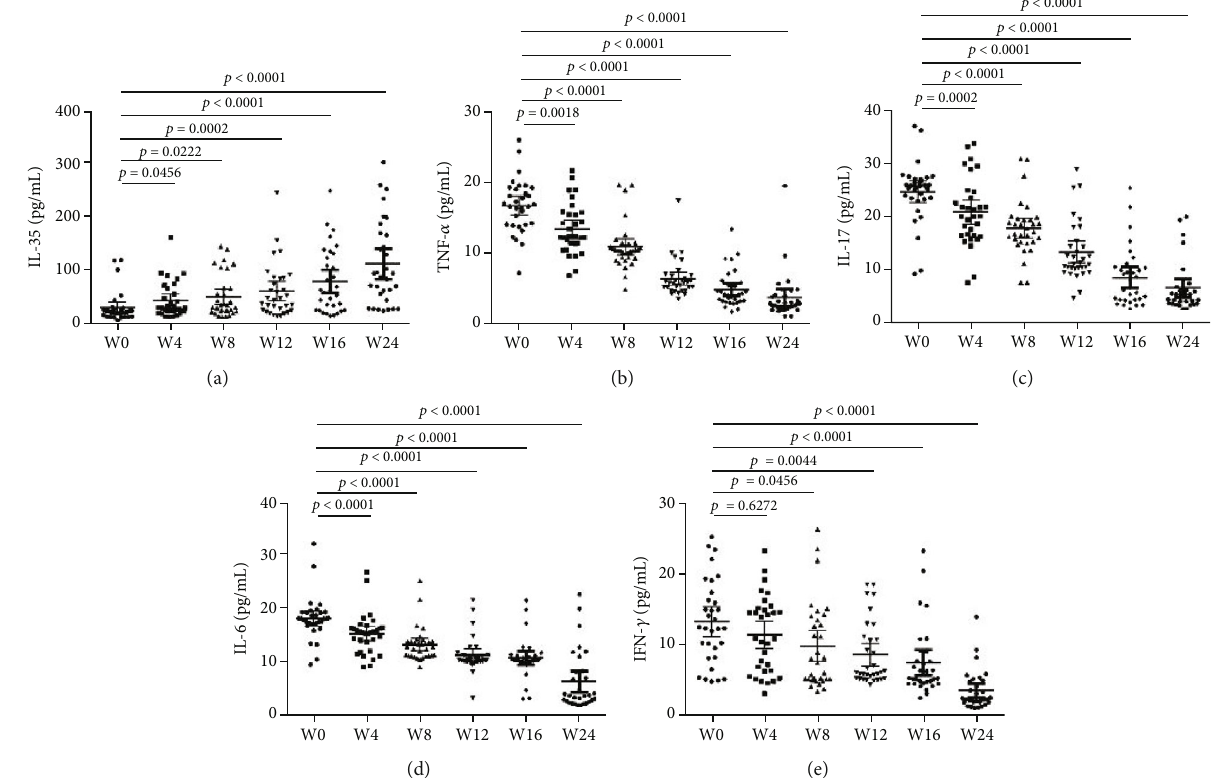
Figure 2: The serum cytokines levels in the RA patients after tofacitinib treatment at the week 0, 4, 8, 12, 16, and 24. (a) IL-35; (b) TNF- α (c) IL-17; (d) IL-6; (e) IFN- γ . Abbreviations: IL: interleukin; TNF: tumor necrosis factor; IFN: interferon. The x -axis is the six measurement time points indicated as 0, 4, 8, 12, 16, and 24 weeks after tofacitinib treatment is